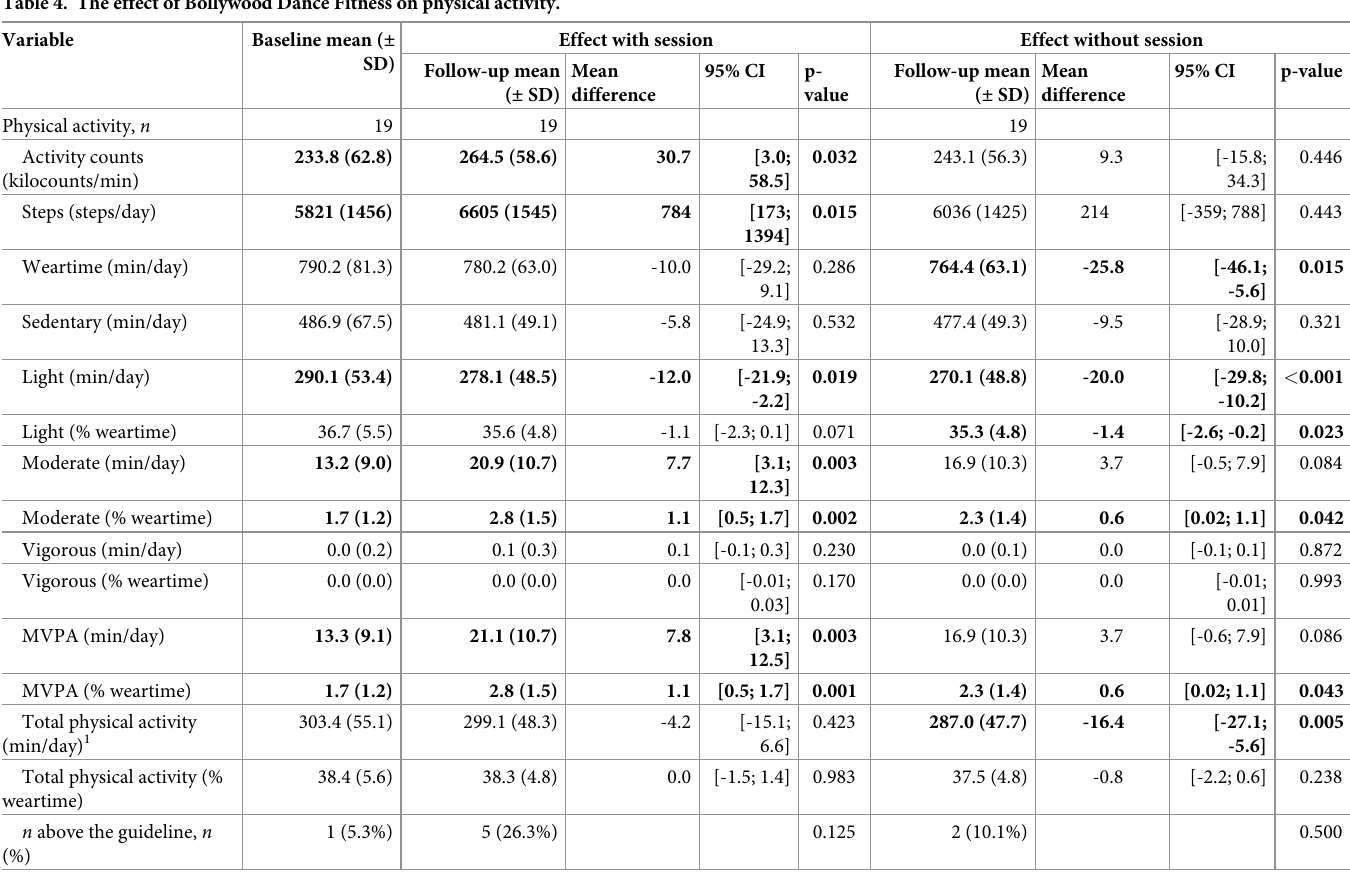
Table 4. The effect of Bollywood Dance Fitness on physical